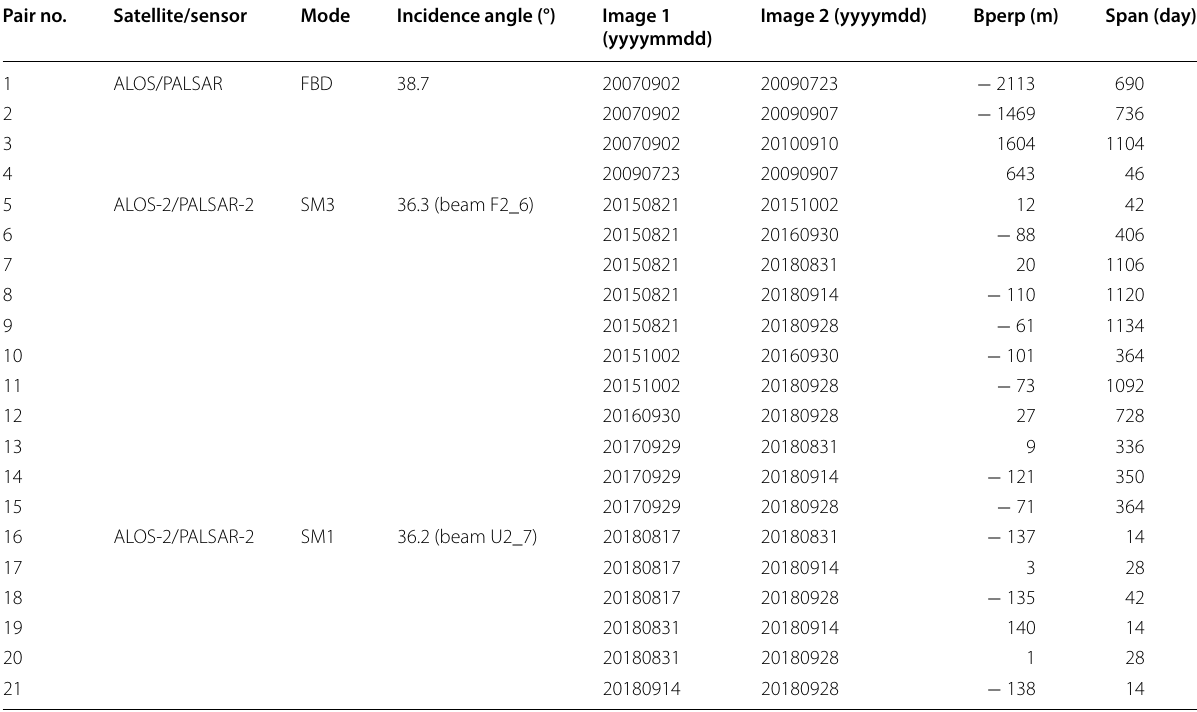
PALSAR and PALSAR-2 SM3 datasets are acquired from the ascending track (mostly from south to north) and PALSAR-2 SM1 datasets from the descending track (mostly from north to south)